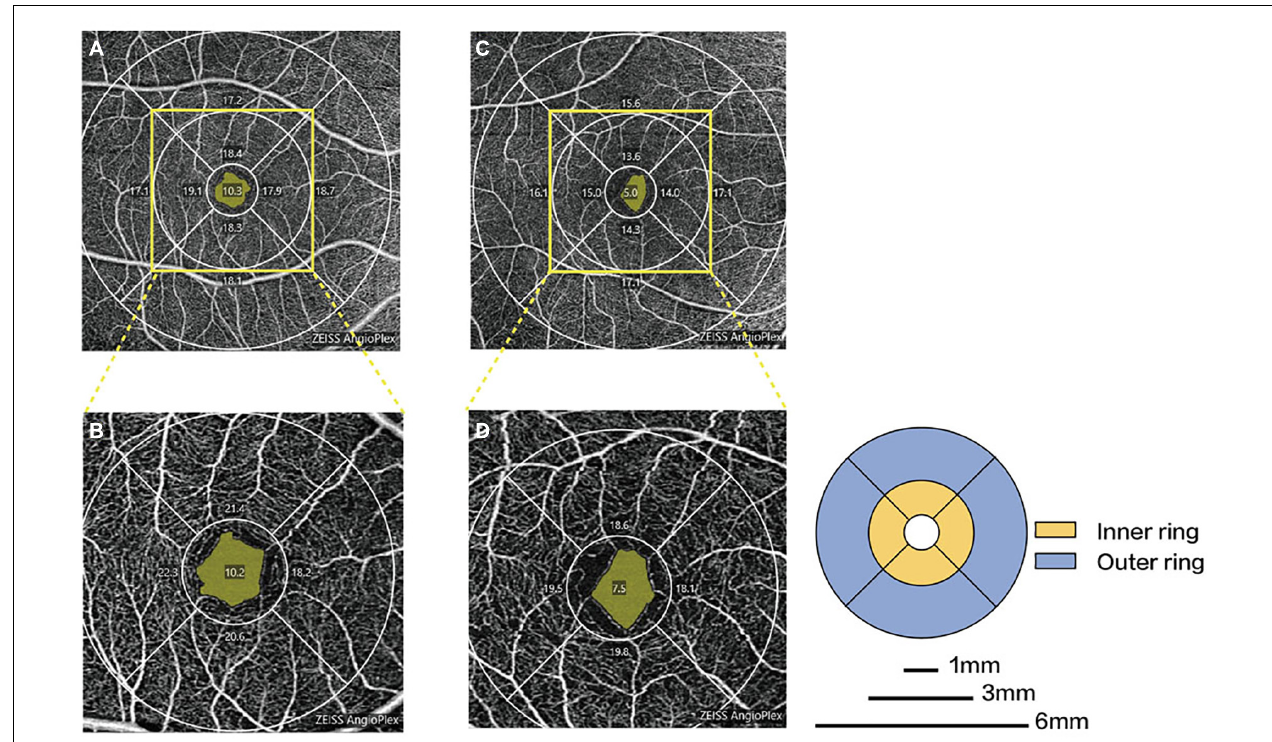
FIGURE 3 | Representative OCTA images in patients with PD and healthy controls. Macular microvascular density of healthy controls (A) and PD patients (C) in the 6-mm-diameter region. Macular microvascular density of healthy controls (B) and PD patients (D) in the 3-mm-diameter region.